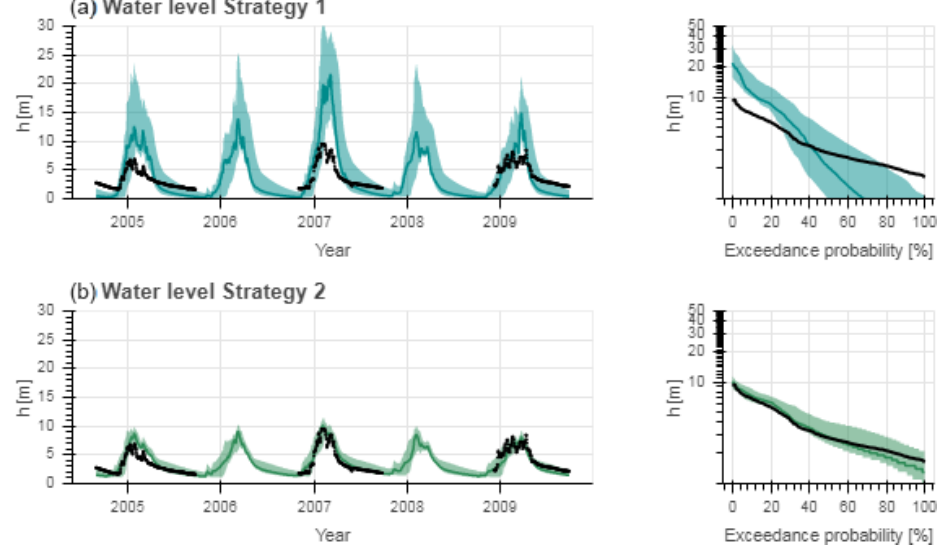
Figure 10. Range of model solutions. The left subplots show the hydrograph and the right subplots the flow duration curve of the recorded (black) and modelled discharge: the line indicates the solution with the highest calibration objective function ( E NS ) and the shaded area the envelope of the solutions retained as feasible. Solutions were retained as feasible based on daily water-level time series at the basin outlet using the Strickler–Manning equation for the discharge–water-level conversion; the cross section was (a) extracted from Google Earth (Water level Strategy 1) or (b) obtained from a detailed field survey with an ADCP (Water level Strategy